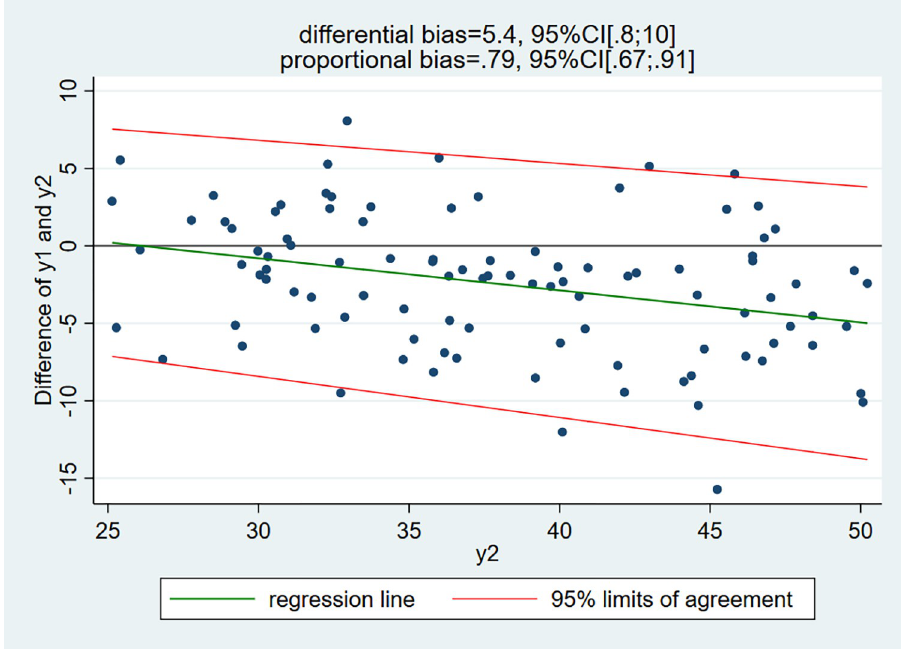
Fig 4. Simulated data: Linear regression of the differences (y1—y2) on y2 with 95% limits of agreement.